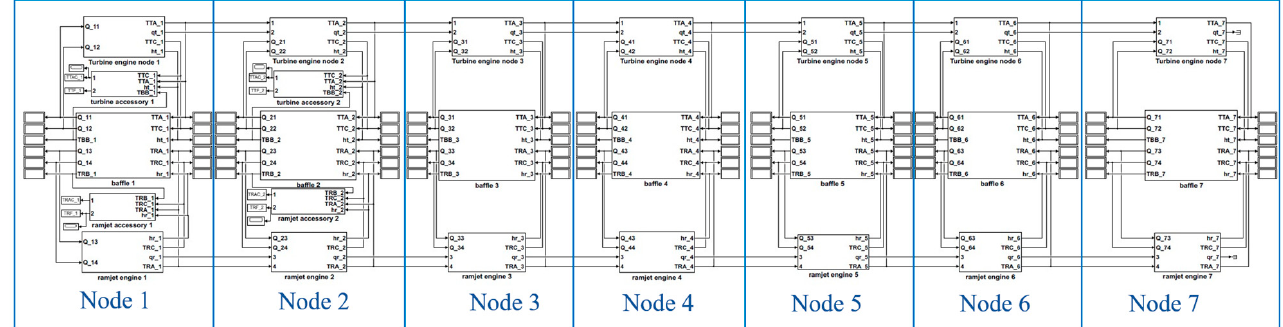
Figure 5. Simulation model of the accessory thermal protection cases. Table 1. Thermal protection method for each component.